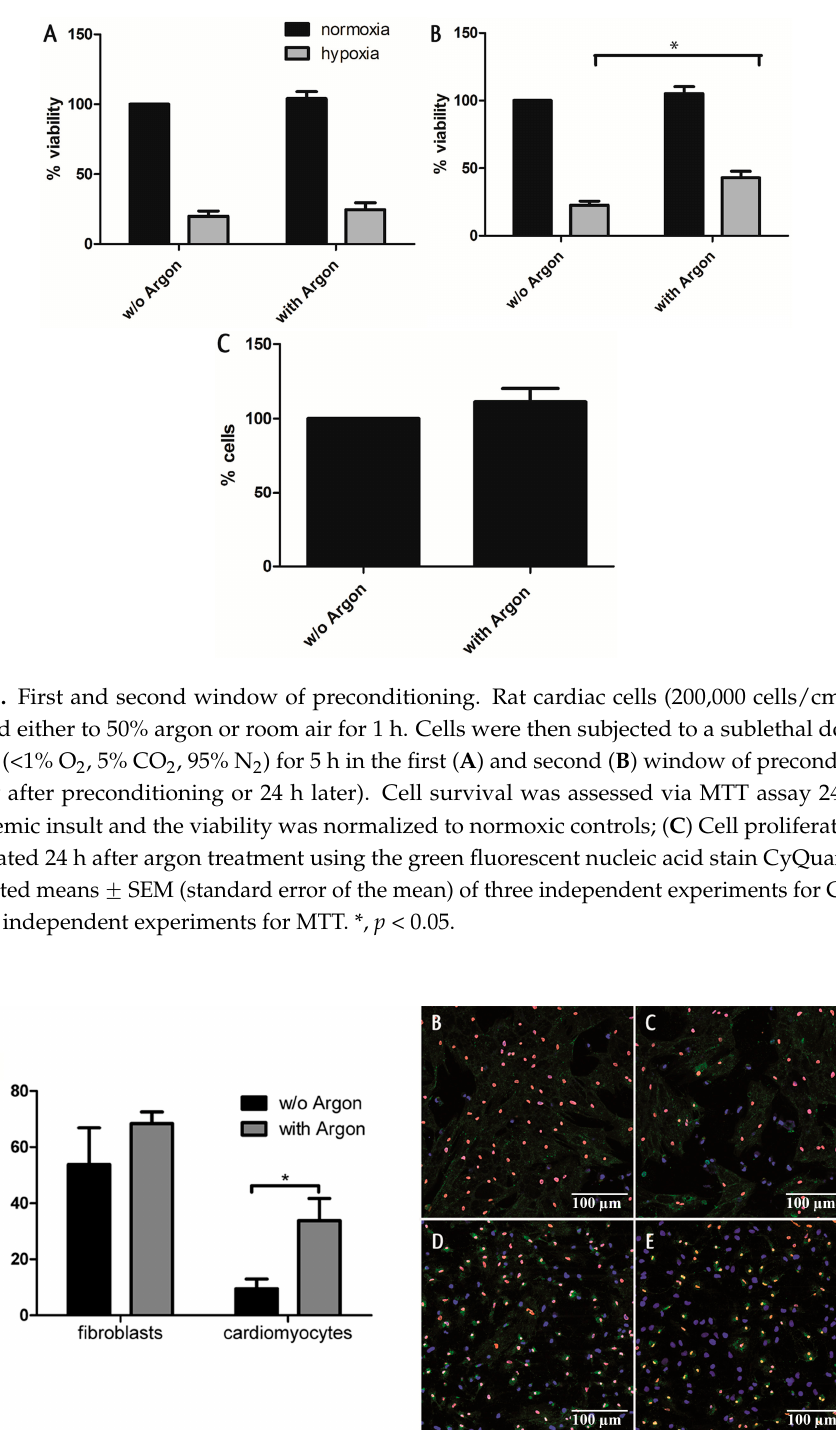
Figure 2. Cell survival in the second window of argon preconditioning (1 h) in either pure cardiomyocytes or fibroblasts. Monocultures of cardiomyocytes and fibroblasts (300,000 cells/ibidi) were treated with 50% argon for 1 h and subjected to 5 h of sublethal hypoxia after 24 h, in the second window of preconditioning. Cells were stained with Hoechst33342 (blue, stains all nuclei), Annexin V (green, stains apoptotic cells), Ethidium homodimer III (red, stains necrotic nuclei). ( A ) Quantification of ( B – D ) expressed as % viability (number of necrotic nuclei/all nuclei, normalized to normoxic control cells; ( B ) cardiomyocytes without argon; ( C ) cardiomyocytes with argon; ( D ) fibroblasts without argon; ( E ) fibroblasts with argon. Data represented means ± SEM of five independent experiments. *, p < 0.05.